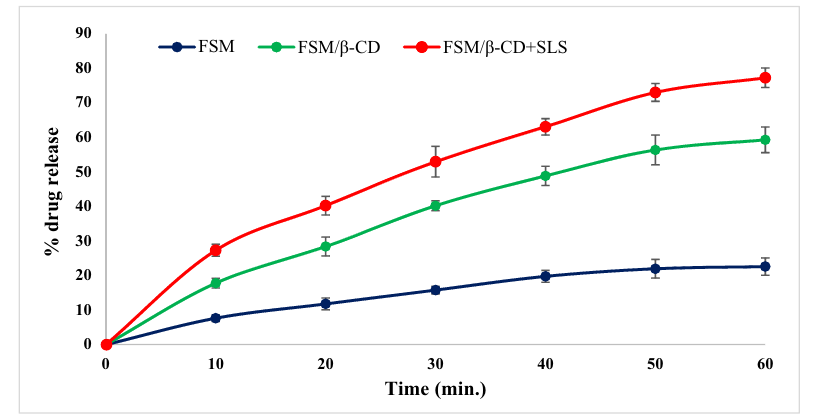
Figure 6: Comparative release pro fi le of complexes.